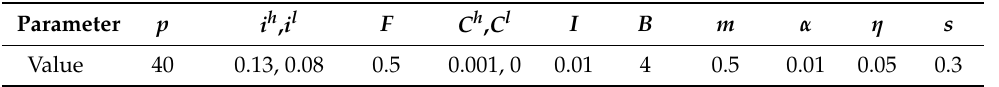
Table 10. Parameter values (when the active online lending platform imposes fewer penalties on defaulting).